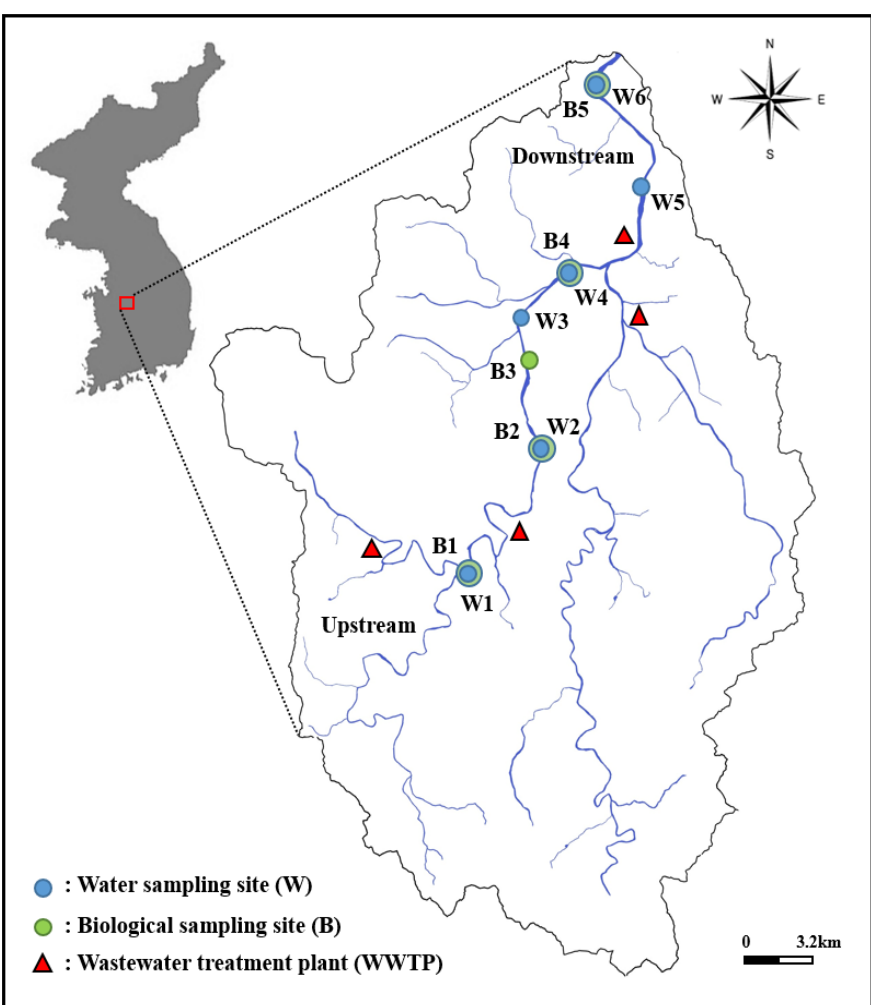
Figure 1. Watershed area and location of water (W) quality and biological (B) sampling sites in Gap Stream, South Korea. Where B1–B5 are the biological (B) sampling sites and W1–W6 are the water (W) quality monitoring sites .